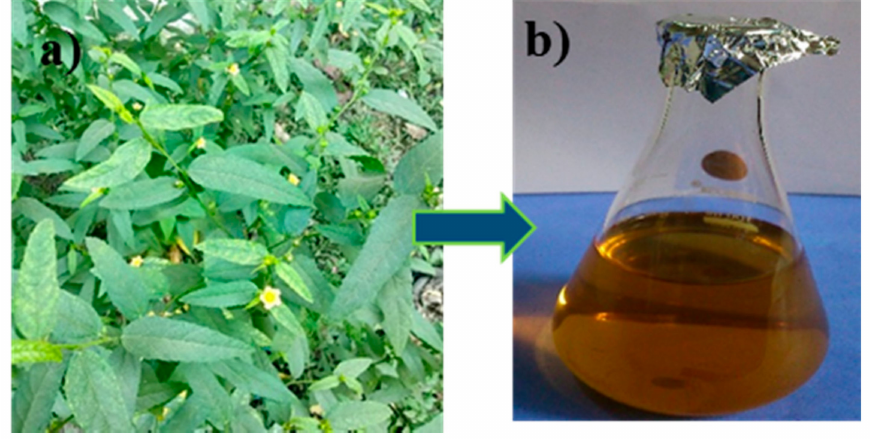
Figure 2. Sida acuta : ( a ) Plant and ( b ) Leaf